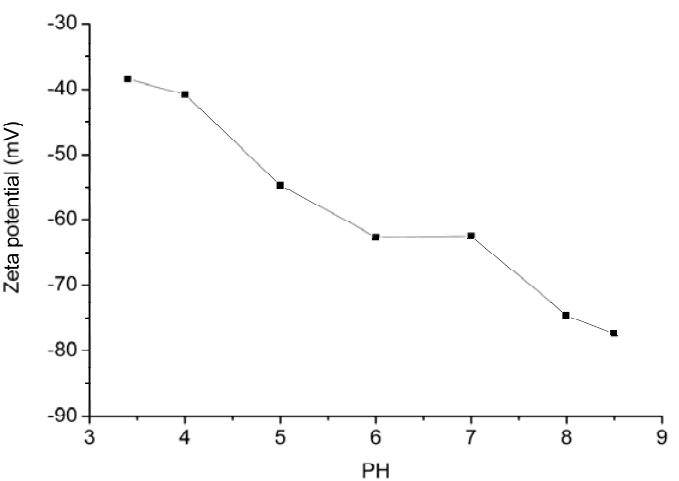
Figure 3. Zeta potential curve vs. pH of